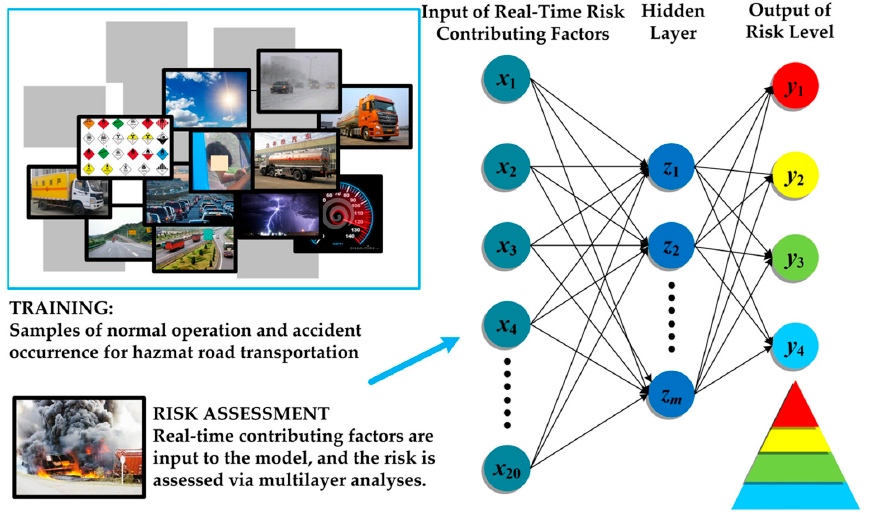
Figure 7. Risk assessment based on DNN.